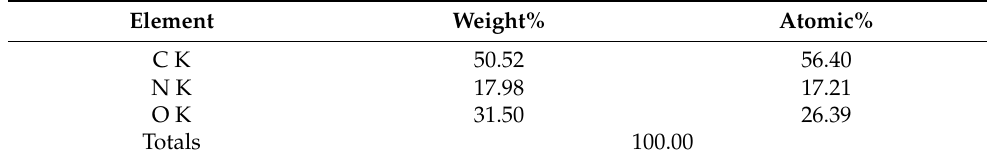
Table 1. Elemental ratio of N-PPB750 (C, O, N). Element